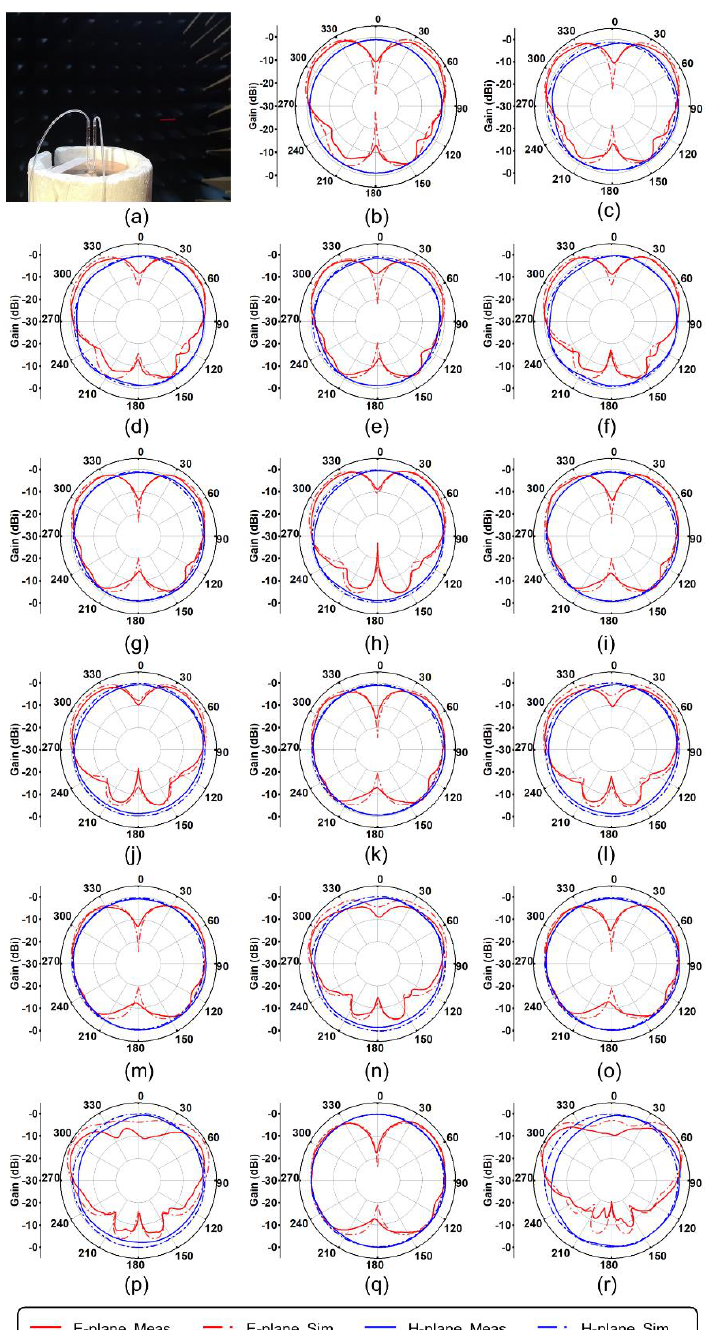
Figure 6. Radiation patterns of E-plane and H-plane (the initial condition: L 1 = L 2 = 10 mm). ( a ) The measurement environment; ( b ) L 1 = L 2 = 10 mm, f L = f H = 3.28 GHz; ( c ) L 1 = 11 mm, f L = 3.12 GHz; ( d ) L 1 = 11 mm, f H = 3.52 GHz; ( e ) L 1 = 12 mm, f L = 2.96 GHz; ( f ) L 1 = 12 mm, f H = 3.78 GHz; ( g ) L 1 = 13 mm, f L = 2.80 GHz; ( h ) L 1 = 13 mm, f H = 4.04 GHz; ( i ) L 1 = 14 mm, f L = 2.70 GHz; ( j ) L 1 = 14 mm, f H =